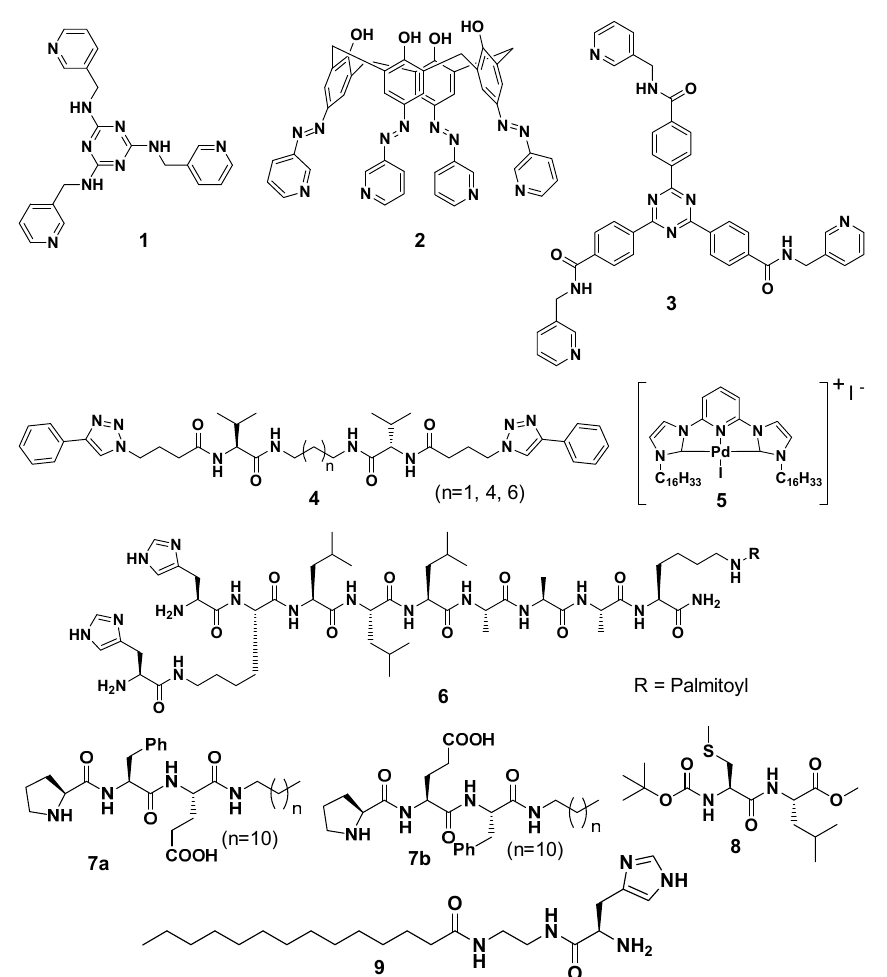
Chart 1. Key compounds used for developing supramolecular gel ‐ based chemical catalytic systems.